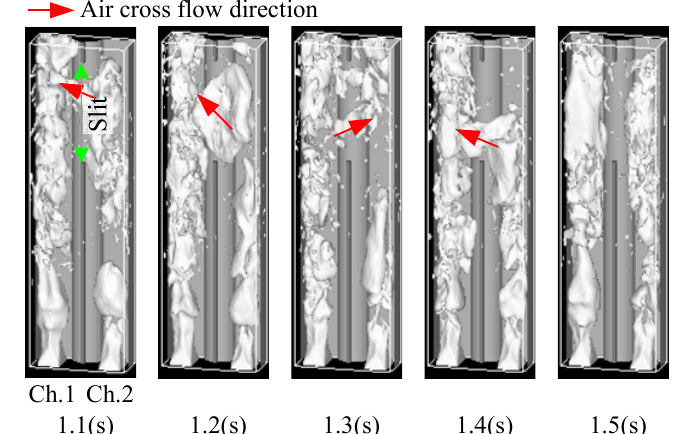
Fig.3 Observed and calculated slug behavior of case 1-5.